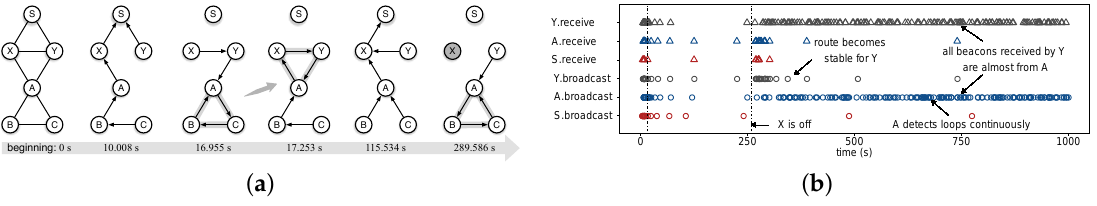
Figure 4. Snapshots and beaconing of the CTP in experiment T-II, during which node X is shut down at the 260th second. The qualities of link l XS and l YS in T-II are the same as that of link l XS in T-I in terms of dynamics. In the beaconing plots, for the clarity, we only show randomly-sampled 20% of the points after time 260 s for two kinds of beaconing events, “A.broadcast” and “Y.receive”. ( a ) critical snapshots; ( b ) route